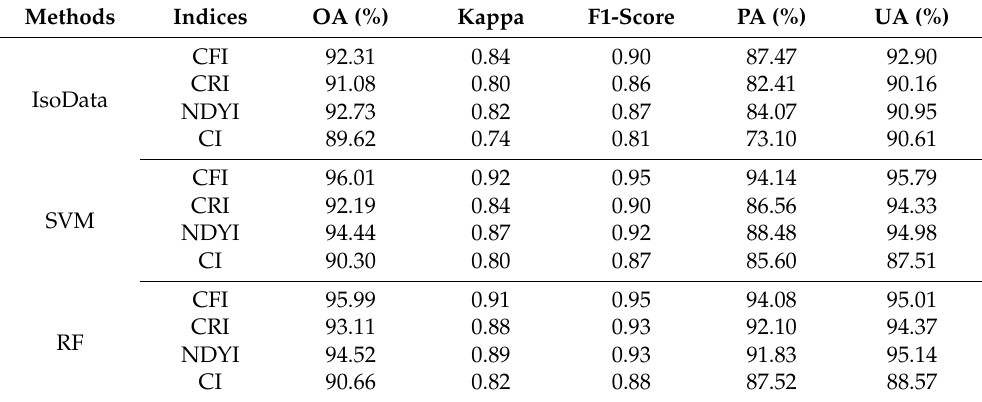
Figure 9. Canola area scatterplot of validation quadrats from ground-truth surface samples and classification result samples. RMSE denotes the root mean square error. Table 7. Classification accuracy of different canola indices by using different